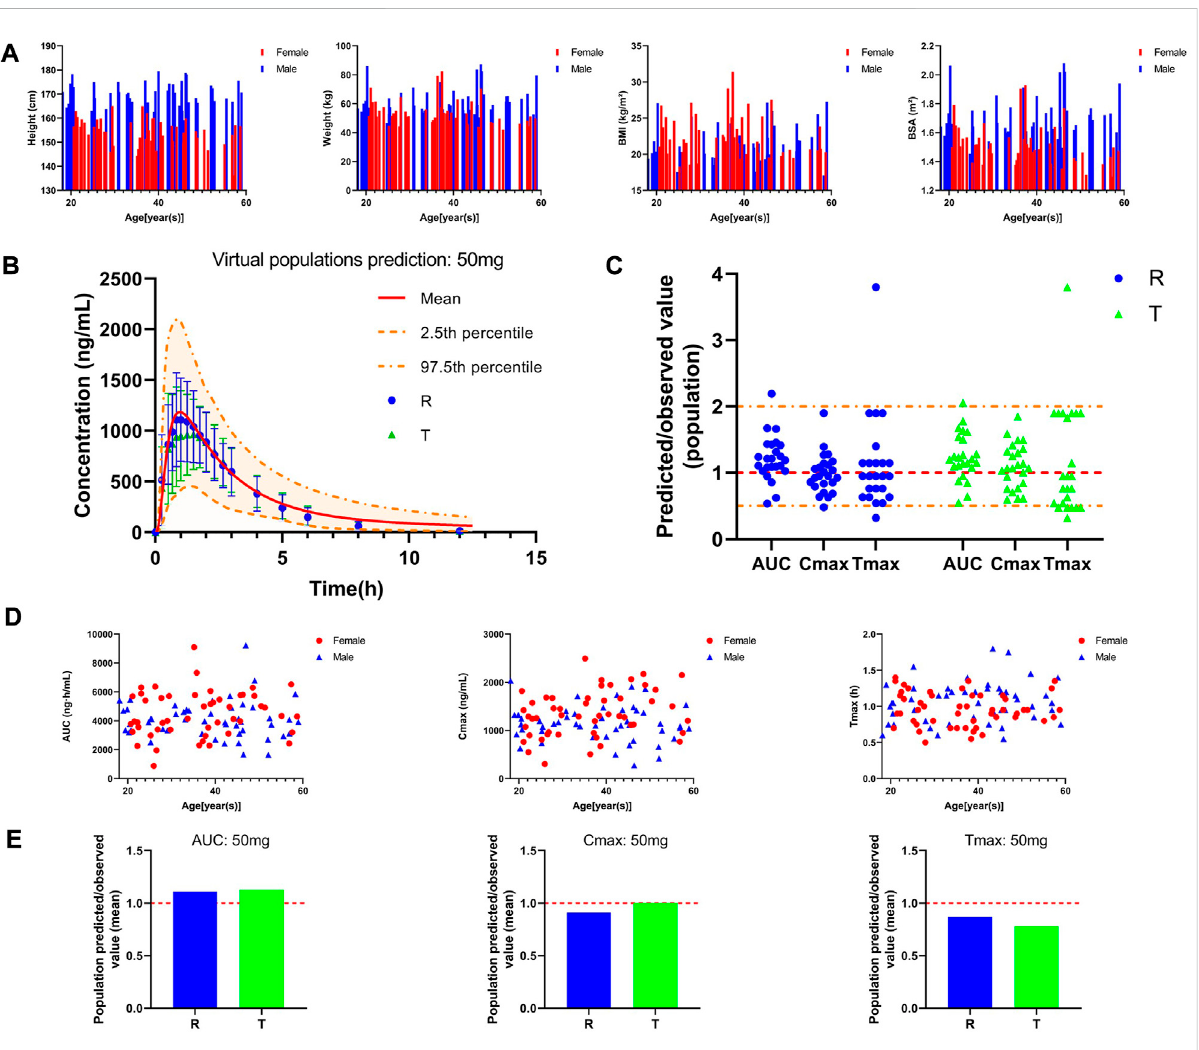
FIGURE 4 Pharmacokinetic characteristics of the virtual adult population after oral administration of 50 mg PTU. (A) Individual information of the virtual adult population; (B) Predicted plasma concentration-time curve in the virtual adult population and observed value, red solid line: predicted population mean curve, yellow dashed lines and areas: 97. fi fth and 2. fi fth percentile predicted values and 95% CI of predicted values, blue circles: observed value (R) and 2 ✕ standard deviation, green triangles: observed value (T) and 2 ✕ standard deviation. (C) Predicted/observed value (population), yellow dashed line: 0.5 and 2-fold error line, red dashed line: 1-fold error line. (D) Individual pharmacokinetic parameters in the virtual population. (E) Predicted/observed value (mean), red dashed line: 1-fold error line.